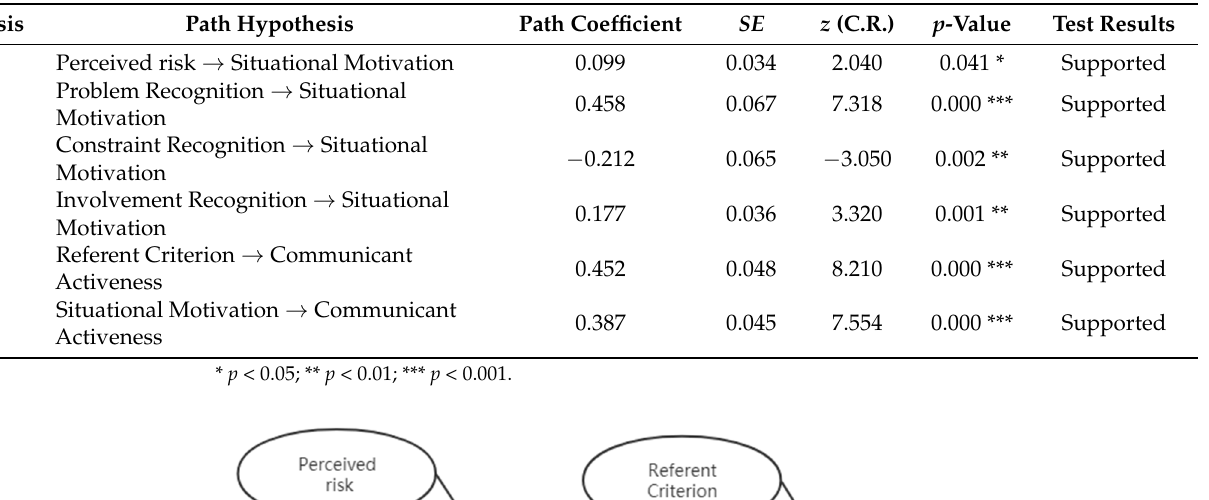
Table 6. Path coefficient of the research model.